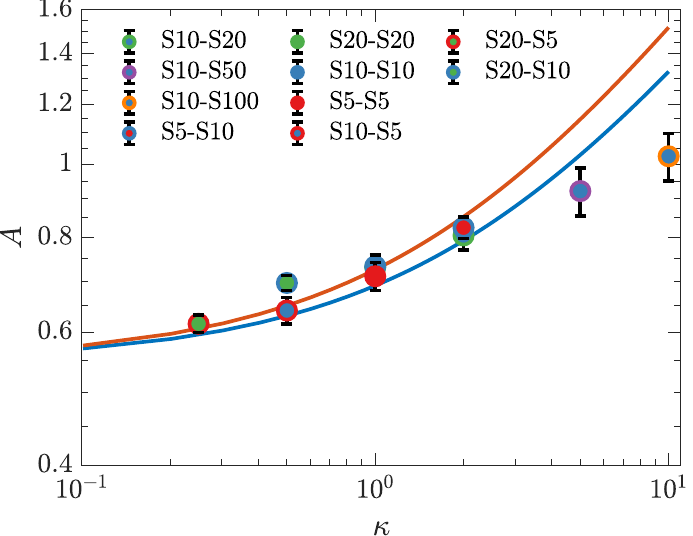
Figure 7. Dependence of the parameter A , defined in (28), on the viscosity ratio κ ≡ ν f / ν d . Com- parison of the experimental data with the theoretical predictions. The orange line and the blue line represent the upper and the lower range of Equation (30) with δ = 0.02 for the blue line and δ = 0.06 for the orange line. The drop diameter has been varied from 1.5 mm to 3.3 mm while the impact velocity is in the range from 2.45 m/s to 4.23 m/s. The fluid combinations used are expressed by the acronym Sxx-Syy, where Sxx denotes the drop and Syy denotes the film liquid.